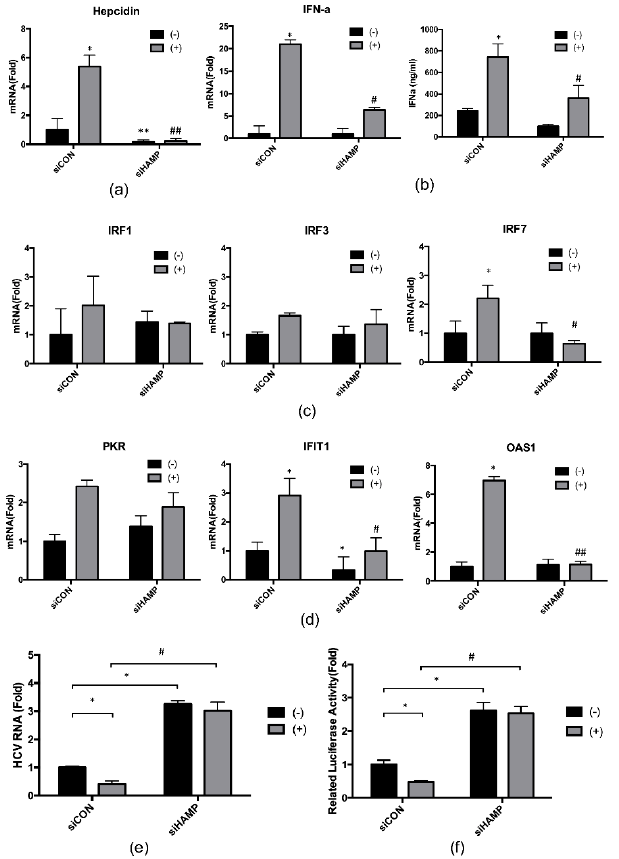
Figure 5. Hepcidin was involved in 4-PBA-mediated IFN- α signaling. Huh 7.5-Con 1 cells were transfected with control siRNA or hepcidin siRNA and treated with 1 mM 4-PBA for 24 h. After incubation, ( a ) hepcidin, ( b , left ) IFN- α , ( c , left ) IRF1, ( c , middle ) IRF3 , ( c , right ) IRF7 , ( d , left ) PKR , ( d , middle ) IFIT1 , and ( d , right ) OAS1 mRNA levels were analyzed by real-time RT-PCR. ( b , right ) siRNA-transfected Huh 7.5-Con1 cells were incubated with 1 mM 4-PBA for 24 h. The medium was changed to serum-free DMEM during the 24-h incubation. After incubation, supernatants were harvested and analyzed using IFN- α -specific ELISAs. HCV replication was measured by ( e ) qRT-PCR and ( f ) luciferase assays. Data are expressed as means ± SDs of five independent experiments. * P < 0.05, ** P < 0.01 versus the untreated siCON-transfected control; # P < 0.05, ## P < 0.01 versus 4-PBA-treated, siCON-transfected control; one-way ANOVA with Tukey’s multiple comparisons